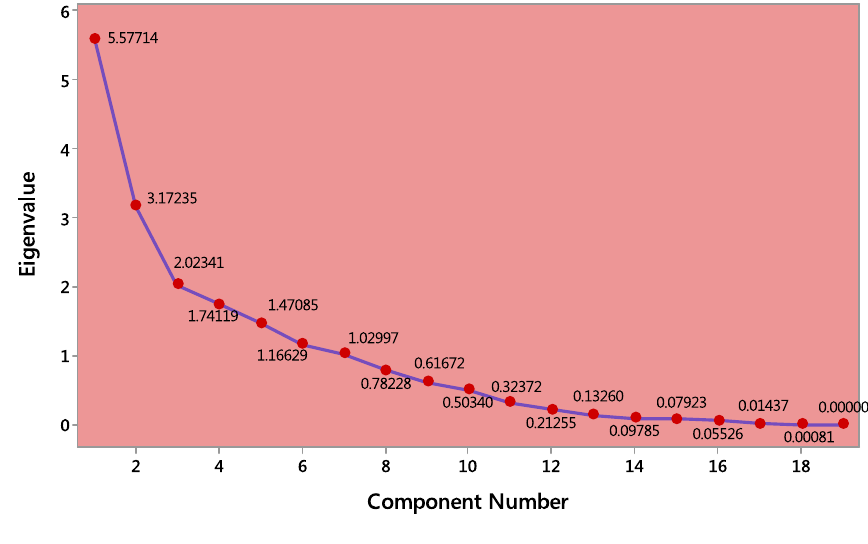
Fig. 2 Screen plot of the eigen- value for each